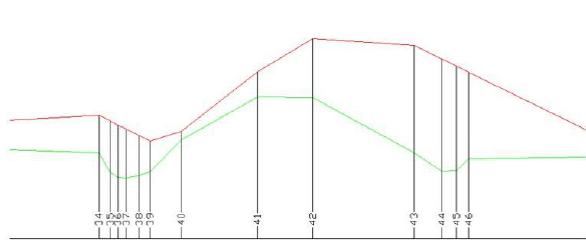
Figure 12. Example of area for which DTMs overestimate elevation. Topographic survey in green, first pulse DSM interpolation in red